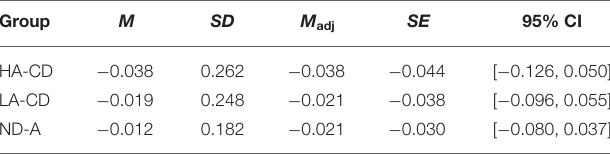
TABLE 3 | The means ( M ) with standard deviations ( SD s) and adjusted means ( M adj ) with standard errors ( SE s) of the one-way between-subjects ANCOVA comparing the relative attentional bias score of the depressed individuals with high or low alexithymic symptoms and never-depressed controls on the relative attentional bias score with the corresponding 95% confidence